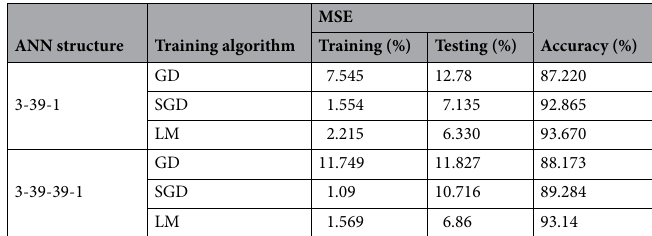
Table 7. MSE and accuracy of the linear regression for GD, SGD and LM algorithms.